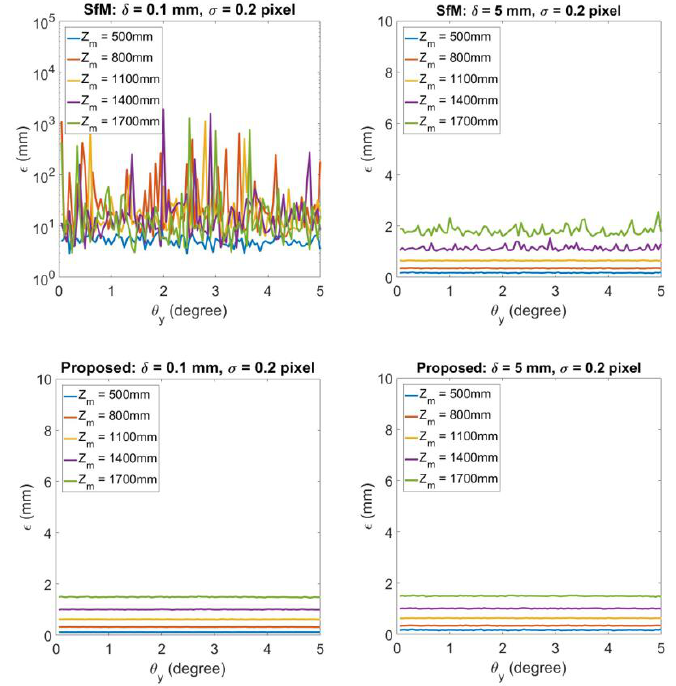
Figure 9. 3D reconstruction error for θ y = 0.05 ◦ ,0.1 ◦ , . . . ,5 ◦ . From left to right each column represents the results for δ = 0.1,5 respectively. For each column, the top figure shows the 3D reconstruction by SfM, while the bottom figure illustrates 3D reconstruction by the proposed degenerate reconstruction